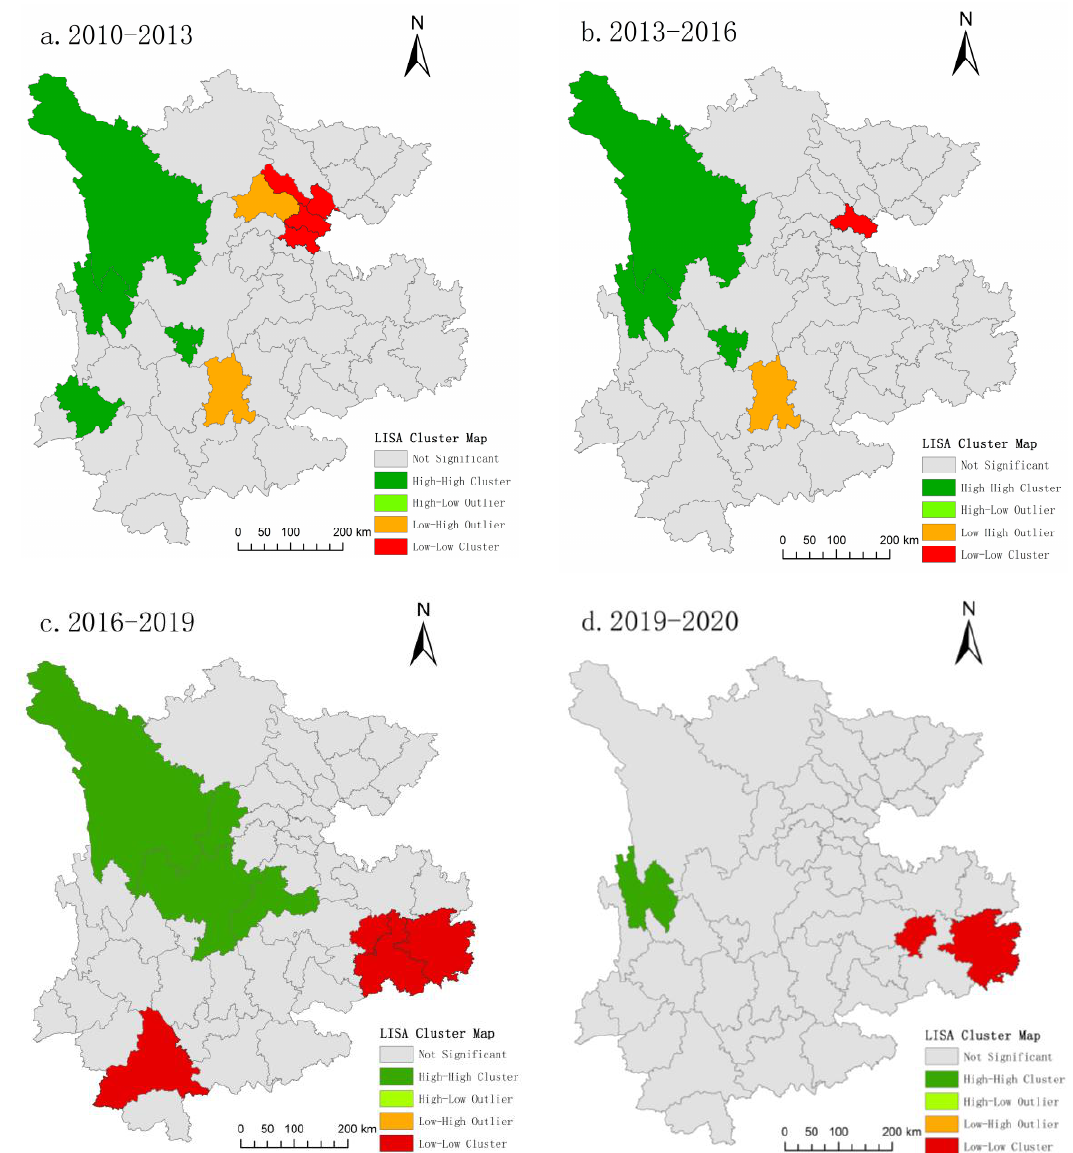
Figure 12. LISA agglomeration from 2010 to 2020: ( a ) LISA agglomeration from 2010 to 2013; ( b ) LISA agglomeration from 2013 to 2016; ( c ) LISA agglomeration from 2016 to 2019; ( d ) LISA agglomeration from 2019 to 2020.